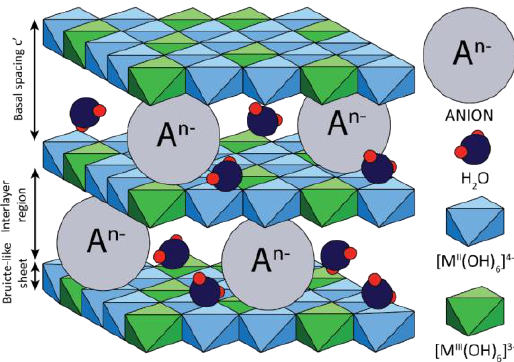
Figure 2. The octahedral unit of brucite-like layers in an hydrotalcite structure.